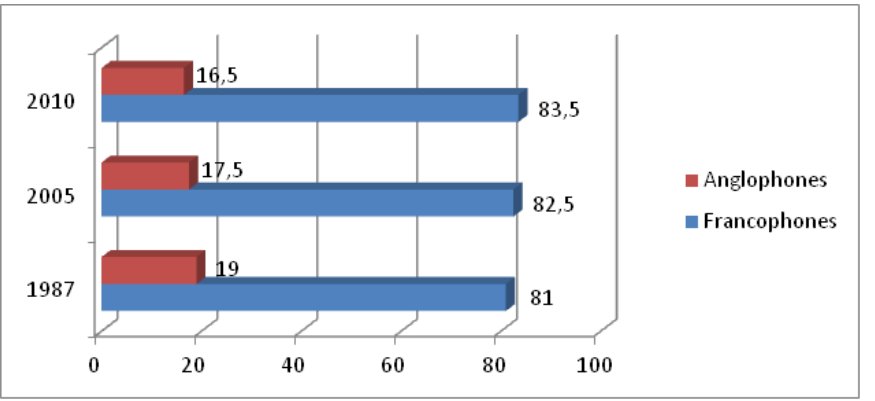
Figure 1. Population of anglophones and francophones 1987-2010 Over the years, anglophones have expressed dissatisfaction with the state because of inequality in the representation of anglophones in government administration, the limited use of English, their first official language, etc. Several protests were organised to this effect, including the All Anglophone Conferences of 1993 (Buea) and 1994 (Bamenda) that published Declarations listing why they are dissatisfied. As multiparty politics was reinstated in the 1990s, the Social Democratic Front (SDF) was formed in the anglophone town of Bamenda and has since become equated with anglophone opposition to the dominantly francophone government. At about the same time, the Southern Cameroons National Council (SCNC), formed after the government refused to react favourably to the 1994 Declaration, launched a bid to secede the anglophone part from the rest of the country. Like the SDF, the SCNC has also become metonymic of anglophones’ struggle for equality. These movements are responsible for the emergence of what Jua and Konings (2004) refer to as the “anglophone nationalism”. Many references are made